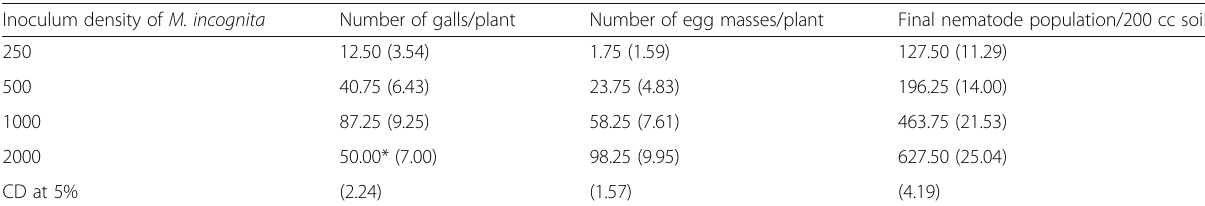
Table 3 Effect of different levels of Meloidogyne incognita in presence of Fictor composticola on infection and reproduction of Meloidogyne incognita in cucumber Inoculum density of M. incognita